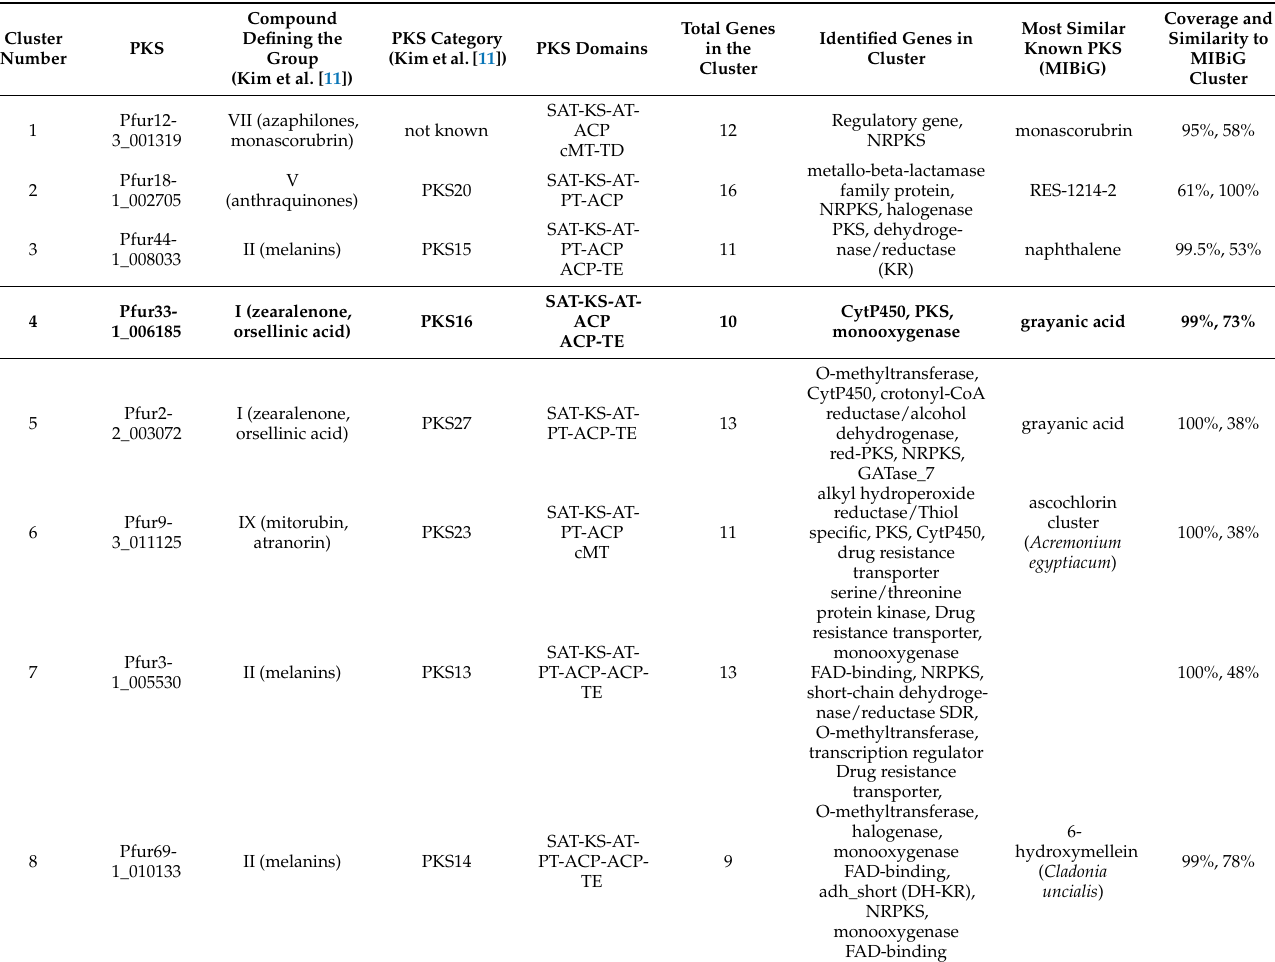
Properties of the NR-PKS clusters detected in both the chemotypes of P. furfuracea . NR-PKS = non-reducing PKS . The cluster in bold, in the box (cluster 4 containing Pfur33-1_006185 ), is the likely cluster for depside/depsidone synthesis. The domain acronyms stand for: KS = keto-synthase, AT = acyltransferase, ACP = acyl carrier protein and KR = ketoreductase. The PKS category is based on the phylogenetic placements of the P. furfuracea NR-PKSs in the PKS groups from Kim et al. [11]. Cluster number refers to Supplementary Table S2 and the PKS number to the antiSMASH cluster, followed by the gene